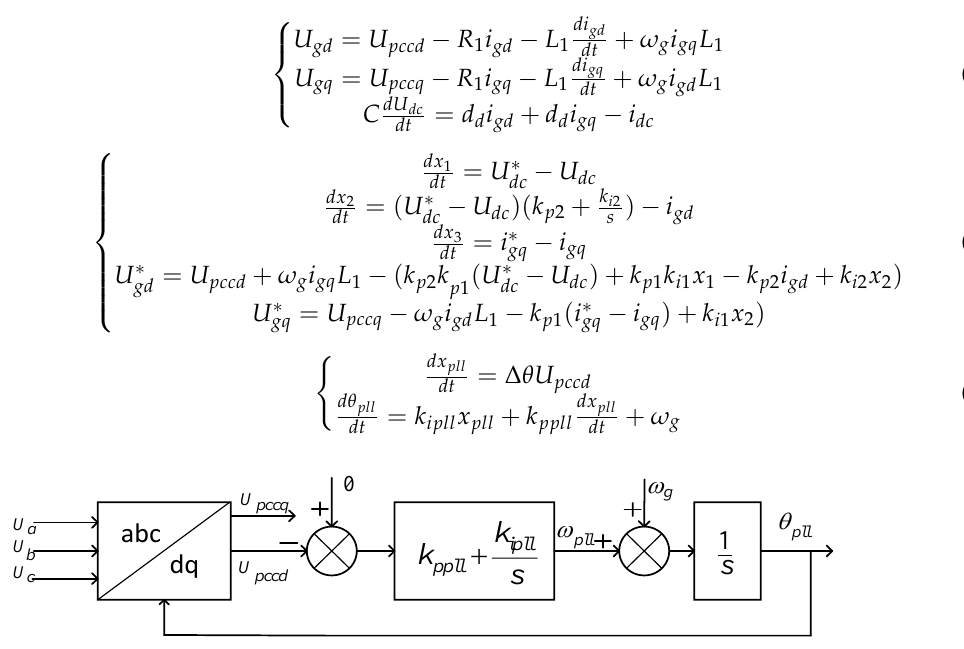
Figure 2. The principle diagram of PLL. According to Equations (1)–(3), the PMSG-based wind farm is modeled with state variable (x = ( x 1 , x 2 , x 3 , x pll , θ pll , i gd , i gq , U dc )) and input (u = ( V pccq , U ∗ matrix is defined by Equation (4), using A and B matrices from Appendix B and parameters from Appendix A. These parameters are based on the 2 MW PMSG model parameters in MATLAB. The system uncertainties arise from PMSG parameter perturbation and grid voltage/DC bus current disturbance, which are organized into nominal and uncertain parts in Equation (5). Figure 3 shows the structure diagram of the uncertain